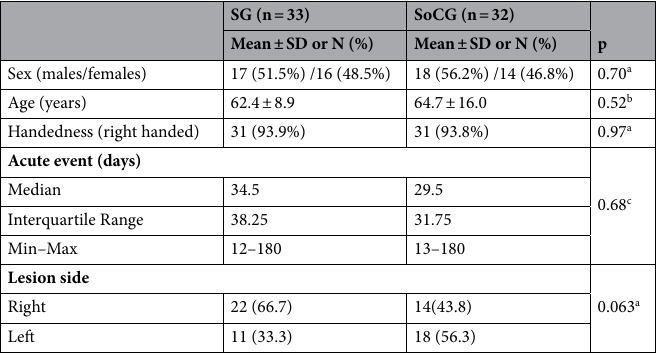
Table 1. Baseline clinical characteristics of patients in Sonification Group (SG) and Standard of Care Group (SoCG). a Chi-square test; b Student’s t test; c Mann–Whitney U